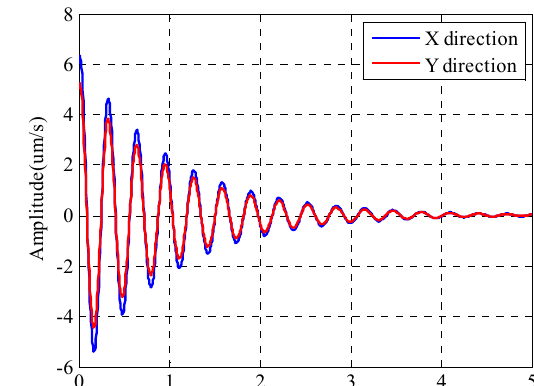
Figure 9. Impact vibration.